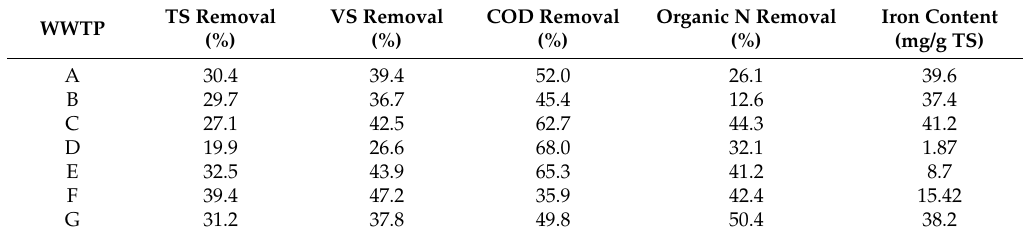
Table 11. Effect of iron content on the TS, VS, COD and N removals in an aerobic digestion process [50]. WWTP